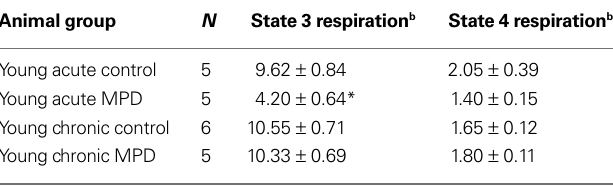
Table 2 | Striatal mitochondrial respiration in acute and chronic young adult (6–10 weeks old) MPD a